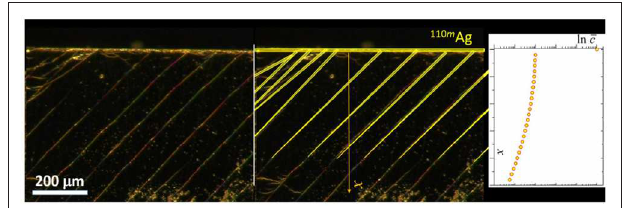
FIGURE 5 | Side-view of a cold-rolled PdNiP glass (left) with a sketch of an anticipated distribution of the 110 m Ag tracer atoms after diffusion annealing (center) and a hypothetical penetration profile measured by a parallel sectioning parallel to the specimen’s surface (right) . It is assumed that a remnant activity on the surface is remaining. A single family of shear bands is c is the layer concentration of the tracer and x is seen with some irregularities. ¯ the penetration